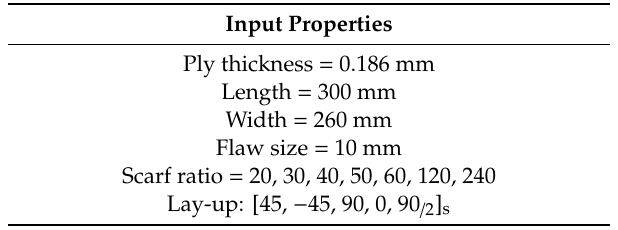
Figure 1. Illustration of rods that were placed onto the upper and bottom faces of the laminate. Table 2. Geometry of the laminate that was analysed.